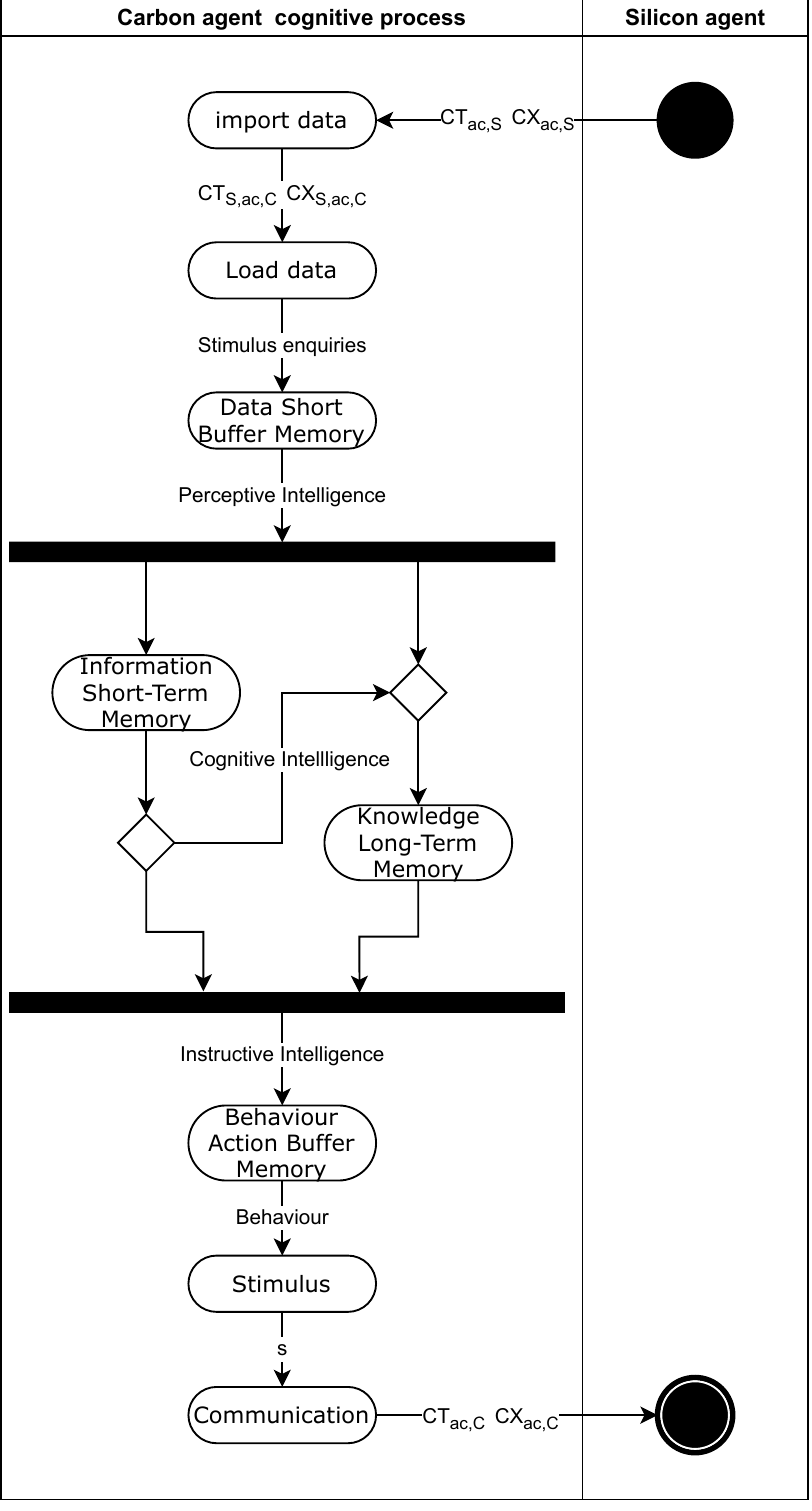
Figure 4. Cognitive info-communication from the carbon agent